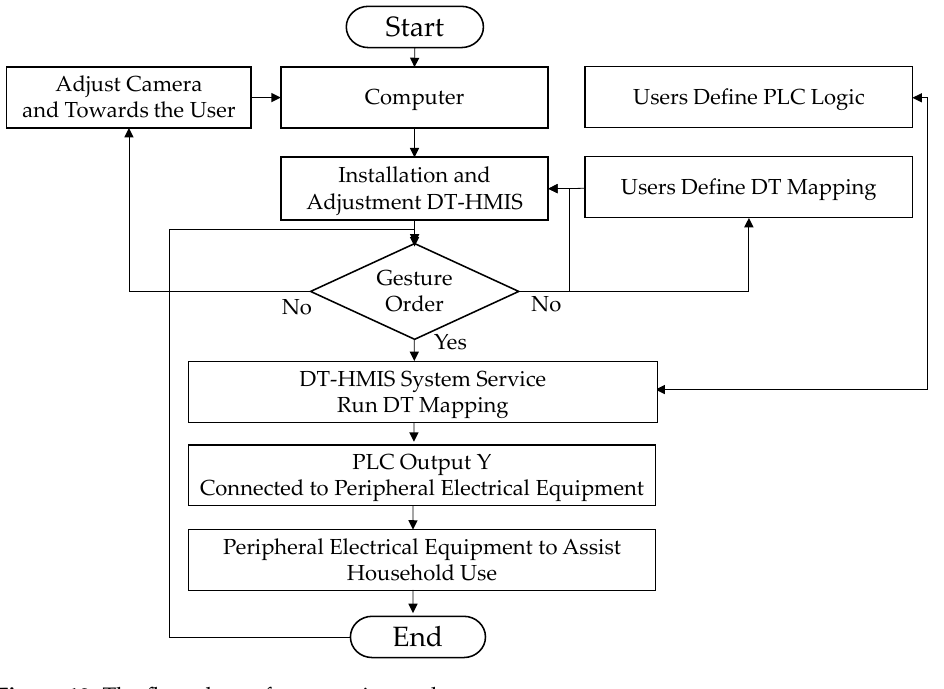
Figure 10. The flow chart of an experimental system.